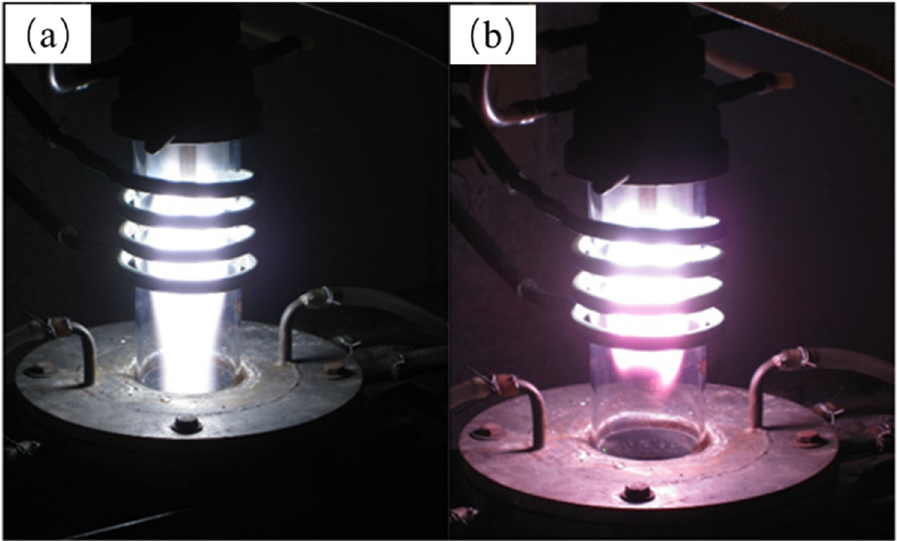
Figure 10. RF plasma jet (( a ) Ar-plasma; ( b ) H-plasma) [90].